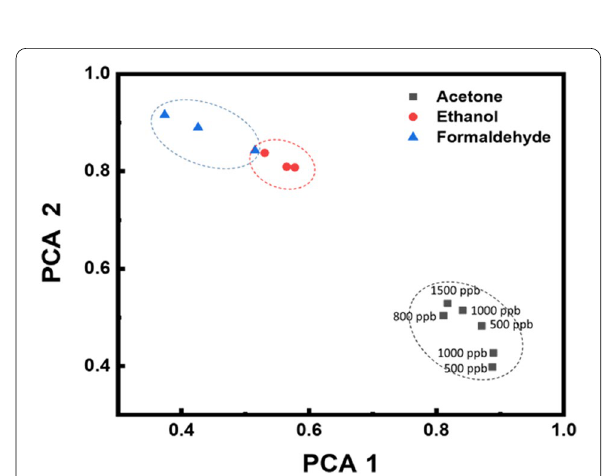
Fig. 7 PCA results of CuO based sensor